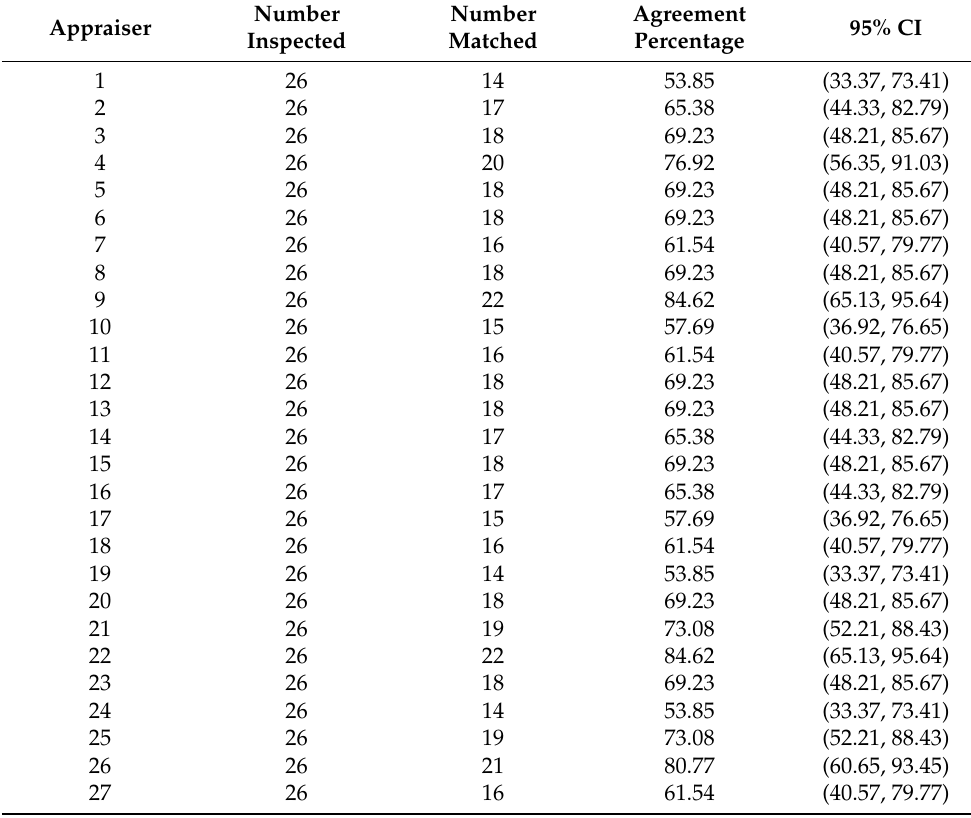
Table A2. Summary of Inspection Accuracy (Appraiser Agreement with Ground